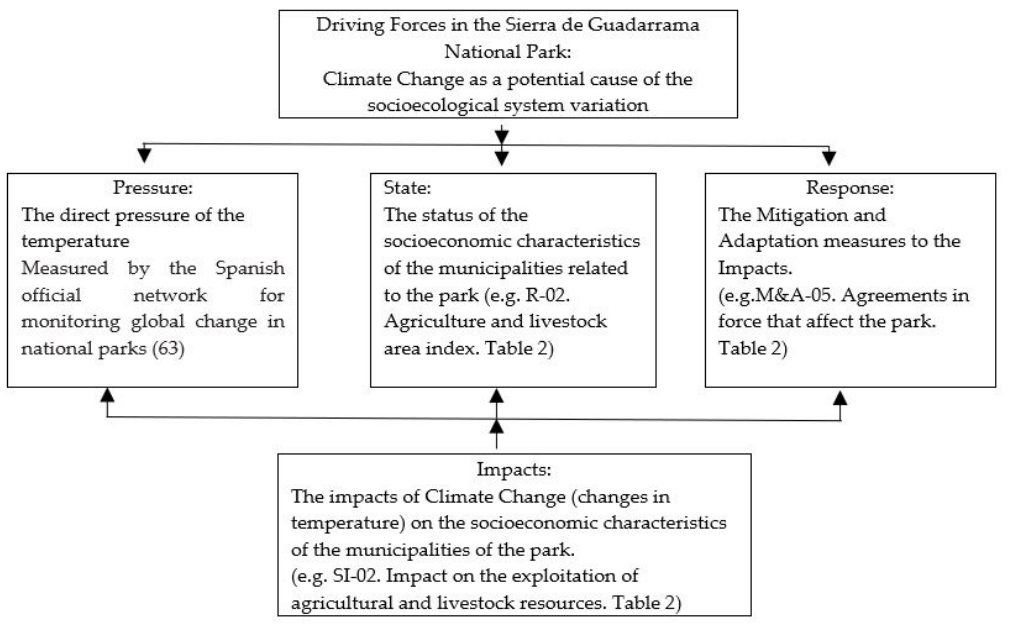
Figure 3. Example of Driving forces-Pressure-State-Impact-Response (DPSIR) scheme.